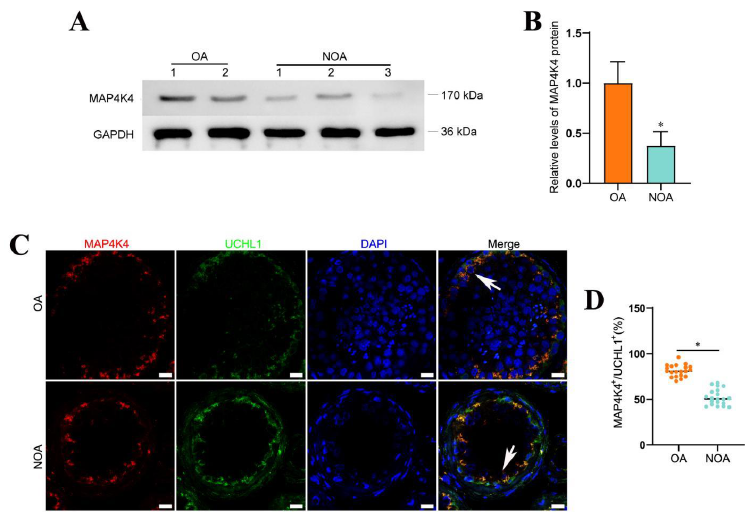
Figure 7. The expression of MAP4K4 in OA and NOA patients. ( A , B ) Western blotting showed the levels of MAP4K4 protein between OA and NOA patients. ( C , D ) The percentages of UCHL-positive cells expressing MAP4K4 (arrows) in OA and NOA patients. Scale bars in C: 100 μ m. * indicates p < 0.05.